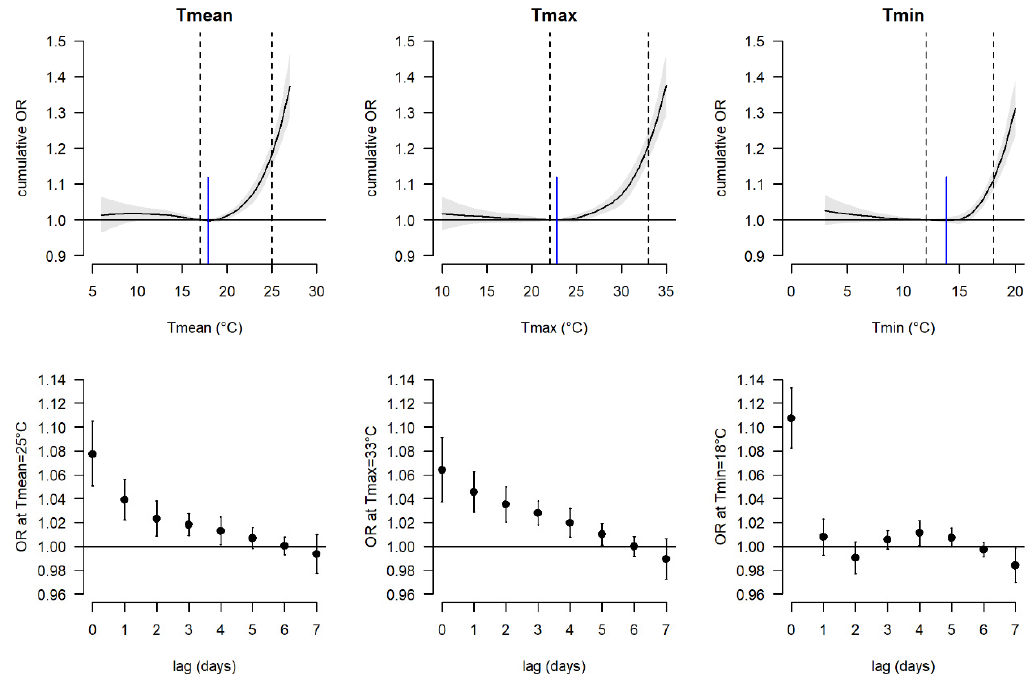
Figure 1. Odds ratios (ORs) of mortality associated with daily mean (Tmean), daily maximum (Tmax), and daily minimum (Tmin) temperature in Switzerland (May–September 2003–2016). Plots in the first row show the cumulative exposure–response association with the 95% confidence interval over one week (lags 0–7). Blue solid vertical lines are minimum mortality temperatures and dashed lines are the 50th (median) and 98th percentiles. Plots in the second row show the lag-specific ORs with 95% confidence intervals at the 98th percentile of the warm-season temperature distribution in respect of the median warm-season temperature.